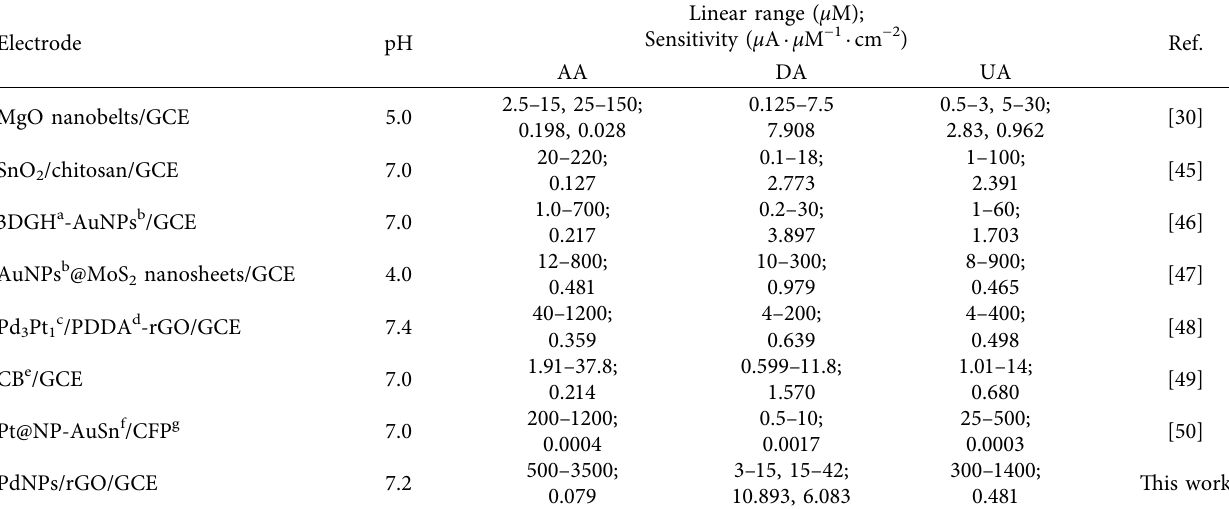
Table 2: Comparison of different electrodes in the simultaneous detection of AA, DA, and UA.